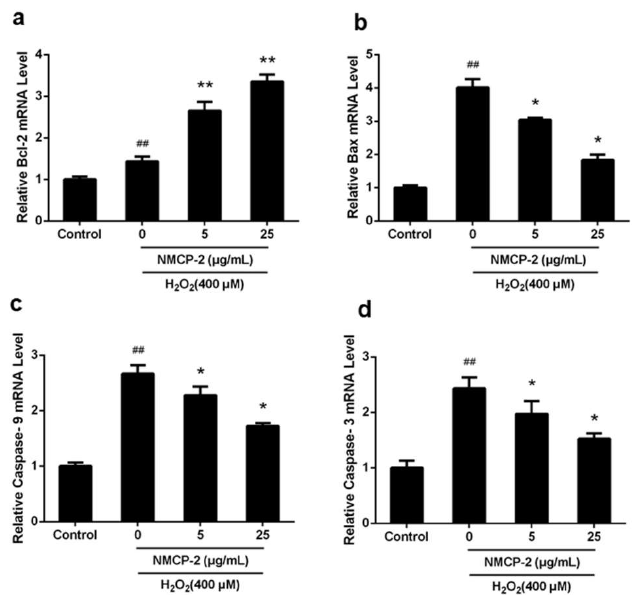
Figure 10. The mRNA expression of genes in the mitochondrial apoptosis pathway. Real-time